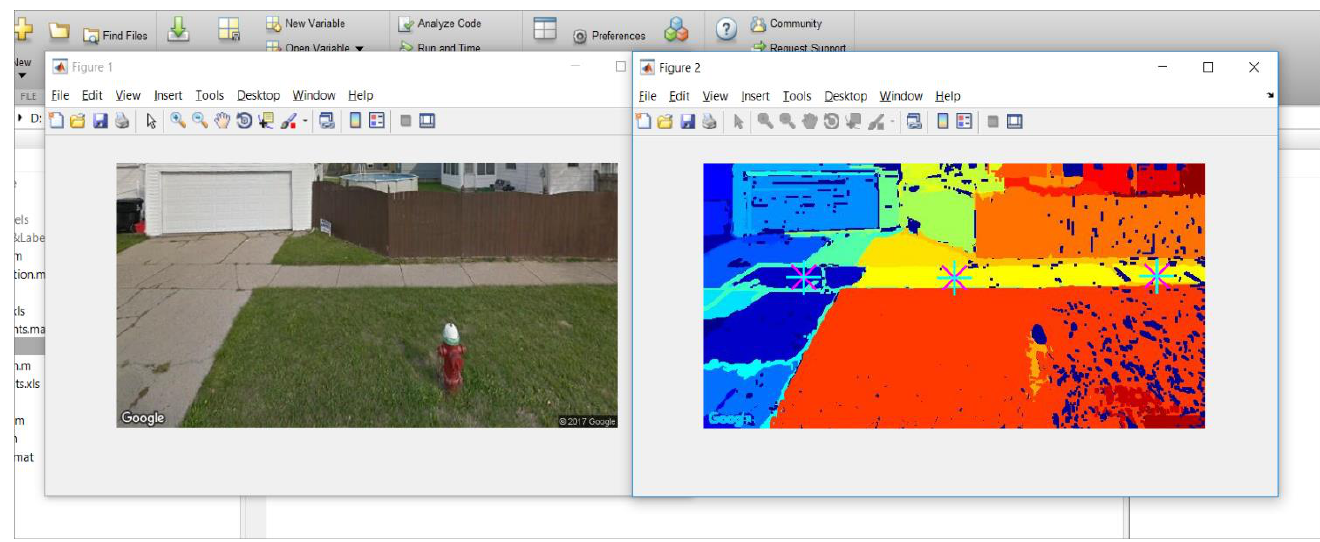
Figure 2. Custom-built software labels sidewalks by visually inspecting the original and segmented images side-by-side. The software asks an analyst to put the pointer where the sidewalk is present and labels the associated segment.